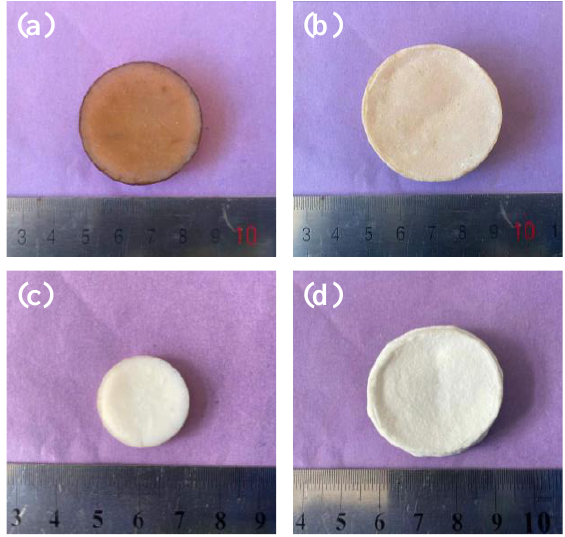
Figure 1. Photographs of AM0 ( a ), AM4 ( b ) as prepared and AM0 ( c ), AM4 ( d ) after heat treatment at 1300 °C.